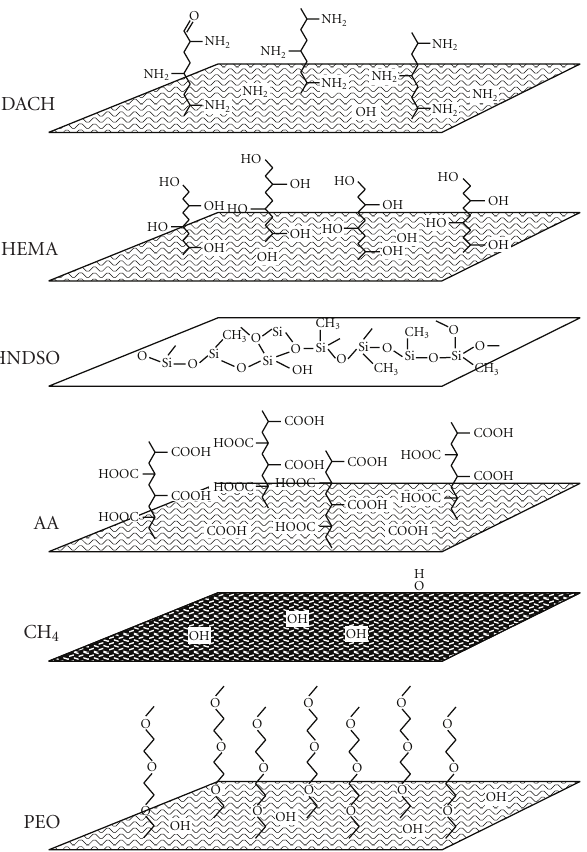
Figure 4: Chemical composition of plasma deposited poly- mer films: diaminocyclohexane (DACH), hydroxyethylmetacry- late (HEMA), hexamethyldisiloxane (HMDS), acrylic acid (AA), methane (CH 4 ) and polyethylene oxide (PEO)